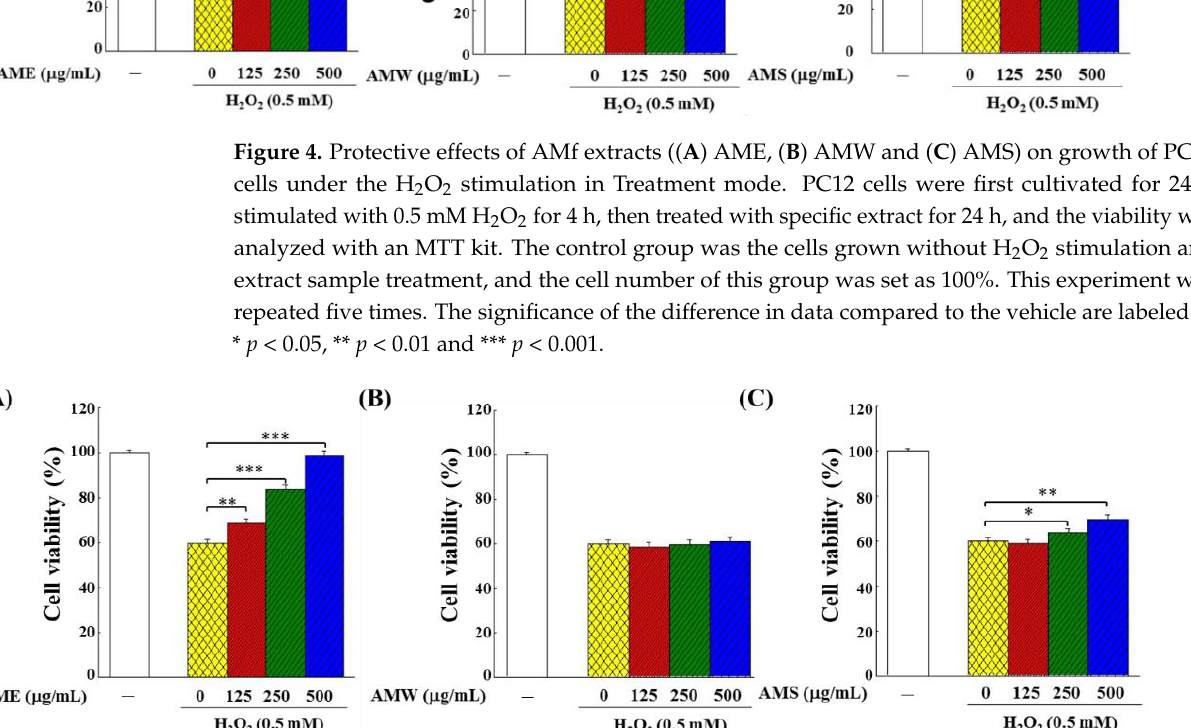
analyzed with an MTT kit. The control group was the cells grown without H 2 O 2 stimulation and extract sample treatment, and the cell number of this group was set as 100%. This experiment was repeated five times. The significance of the difference in data compared to the vehicle are labeled as * p < 0.05, ** p < 0.01 and *** p < 0.001.